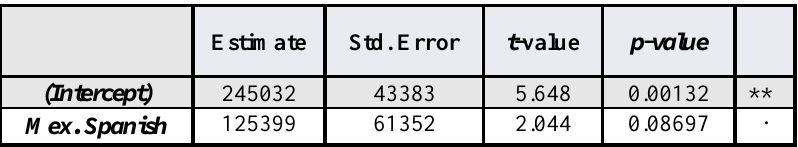
Table 2. Regression coefficients for the fixed linear effects model predicting vowel space area. The Intercept coefficient is vowel space area in Bay Area Spanish and the estimates are measures of Hz squared.